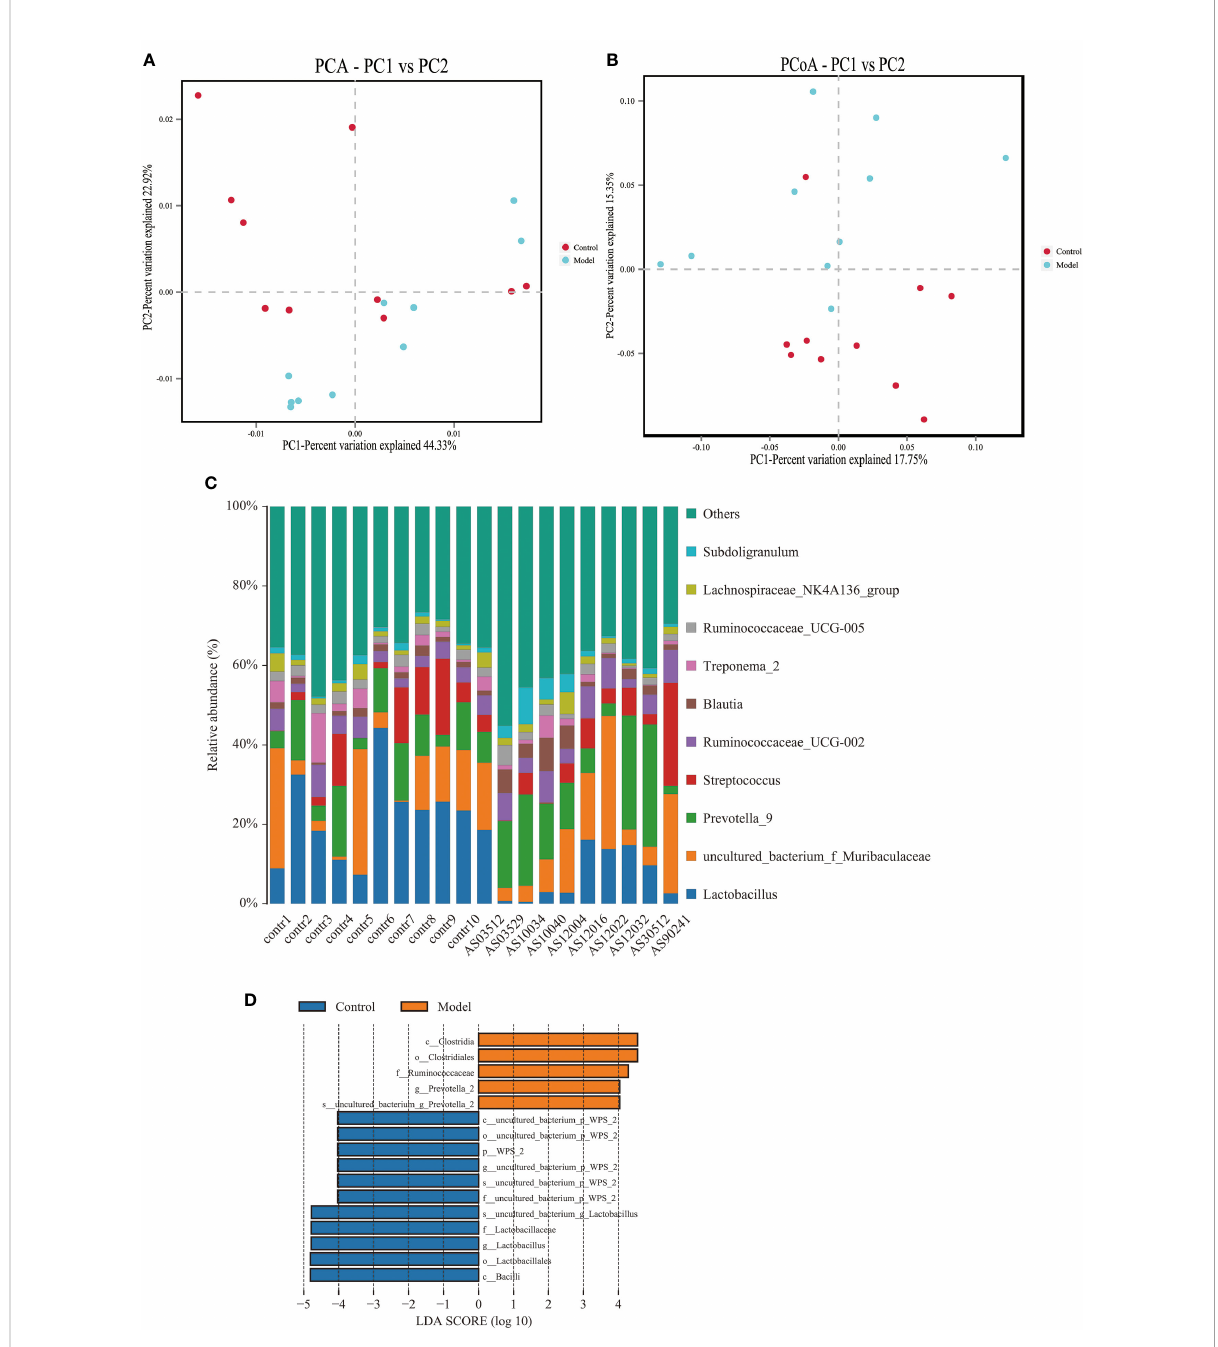
FIGURE 2 Altered bacterial microbiota biodiversity and composition in AS monkeys. (A) Principal Component Analysis (PCA). Note: Dot represents each sample. Different colors represent different groups. The abscissa represents the fi rst principal component, and the percentage represents the contribution value of the fi rst principal component to the sample difference. The ordinate represents the second principal component, and the percentage represents the contribution of the second principal component to the sample difference. (B) Principal-coordinate analysis (PCoA) using the binary Jaccard distance algorithm. The horizontal and vertical coordinates are the two characteristic values that lead to the largest difference between samples, re fl ecting the major in fl uence degree in the form of a percentage. (C) Global composition of bacterial microbiota at the genus levels showing in bar chart. The more details see also in Figures S1, S2. (D) LEfSe (Line Discriminant Analysis (LDA) Effect Size) of AS and health monkeys. Note: The fi gure shows species whose LDA Score is greater than the set value (the default setting is 4.0). The length of the bar chart represents the size of the impact of different species (i.e., LDA Score). Different colors represent species in different